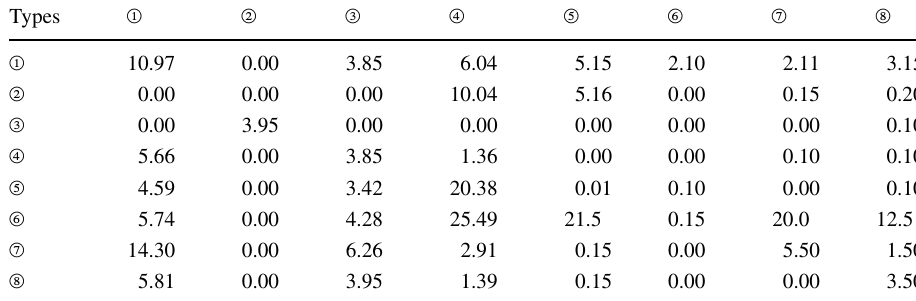
①, ②, ③, ④, ⑤, ⑥, ⑦ and ⑧ represent natural water surface, emerged plants, floating plants, submerged plants, grass beach, wasteland, cultivated land and construction land,